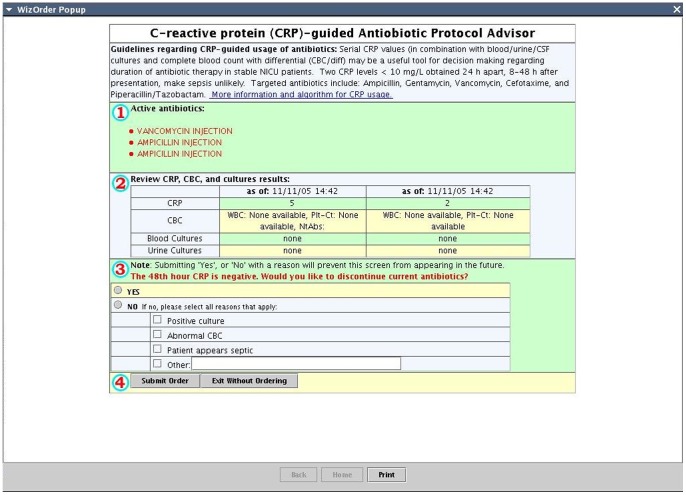
Screenshot decision support to stop antibiotics.The CRP protocol's recommendation on antibiotic use was based on repeat CRP and WBC results drawn 48 hours following initial evaluation. In cases with two consecutively negative CRP results (CRP <10 mg/L), this discontinuation screen appeared, allowing the provider to choose to stop antibiotics. If the provider chose to continue antibiotics despite negative CRP results, they were prompted to provide reasoning for doing so. No complete white blood count (CBC) data is depicted in this screenshot, because a “test” patient had to be generated to produce this figure.